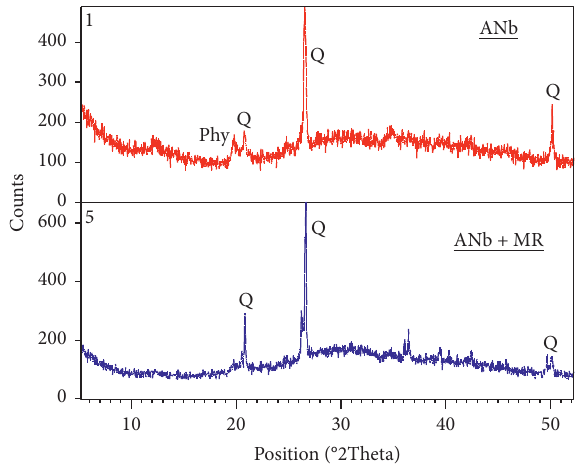
Figure 5: XRD spectra of raw clay before (AB) and after (AB+MR) MR adsorption.